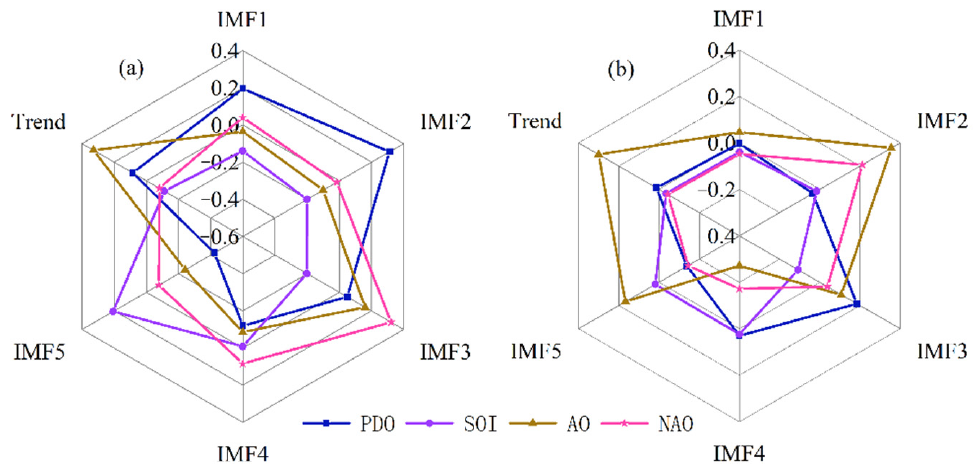
Figure 5. PCC of four ocean oscillation indexes with components of precipitation ( a ) and temperature ( b ) deconstructed by EEMD. Combined with the results in Table 3 and Figure 5, future research on, and predictions of, precipitation in the Pan-Central-Asia arid region should focus on the variation in PDO, followed by SOI. For the research and prediction of temperature, the effect of AO variation should be emphasized (Figure